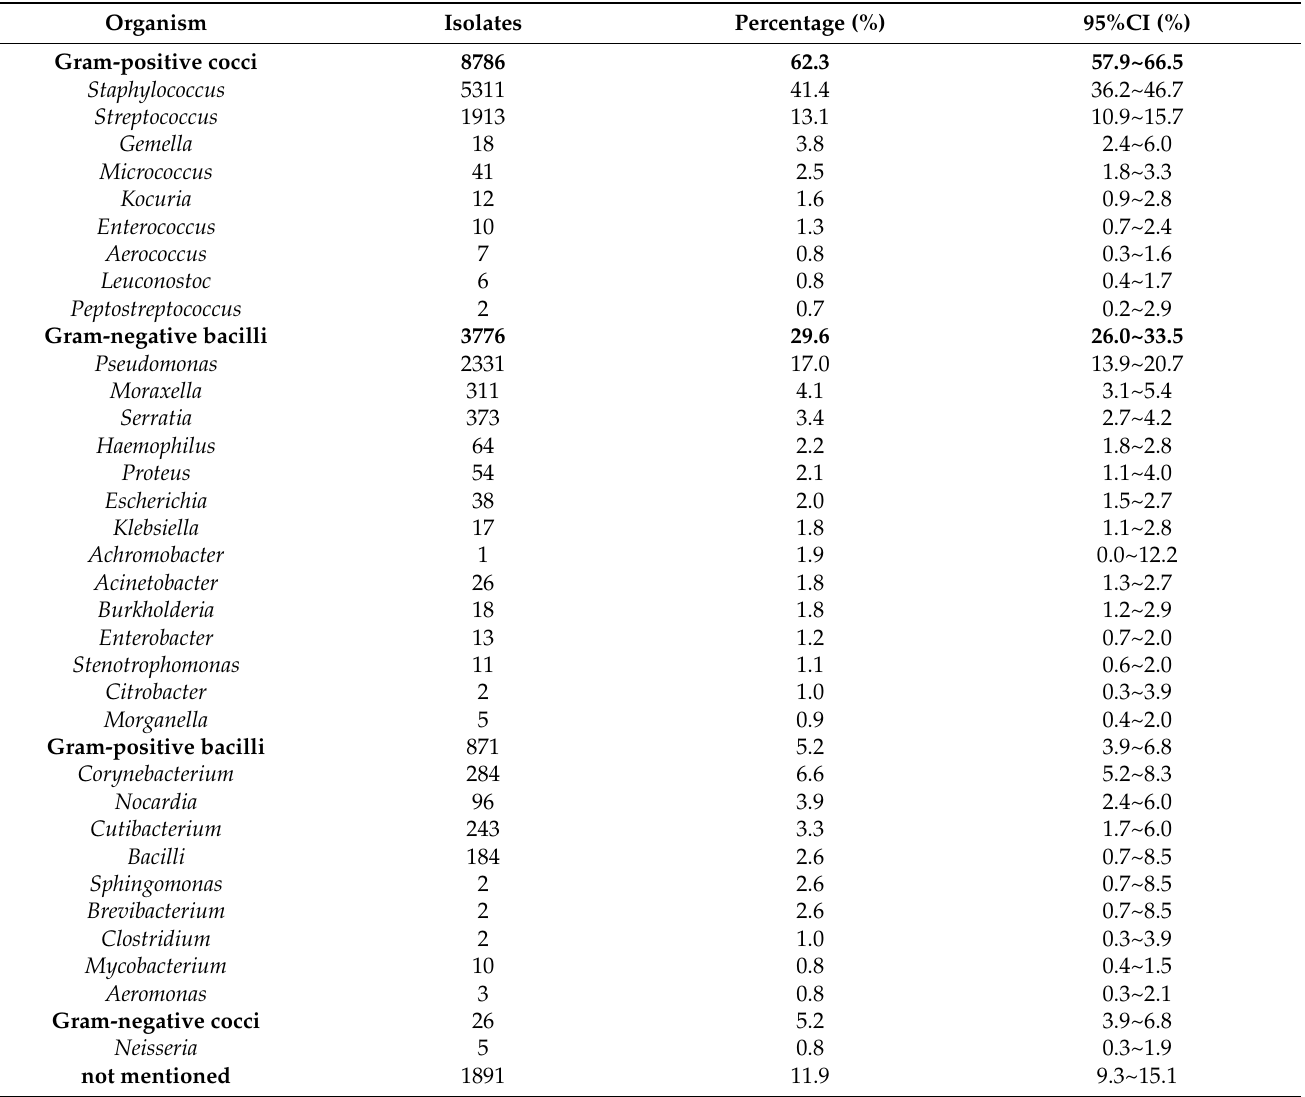
Table 2. Distribution of bacteria isolated from corneal lesions of bacterial